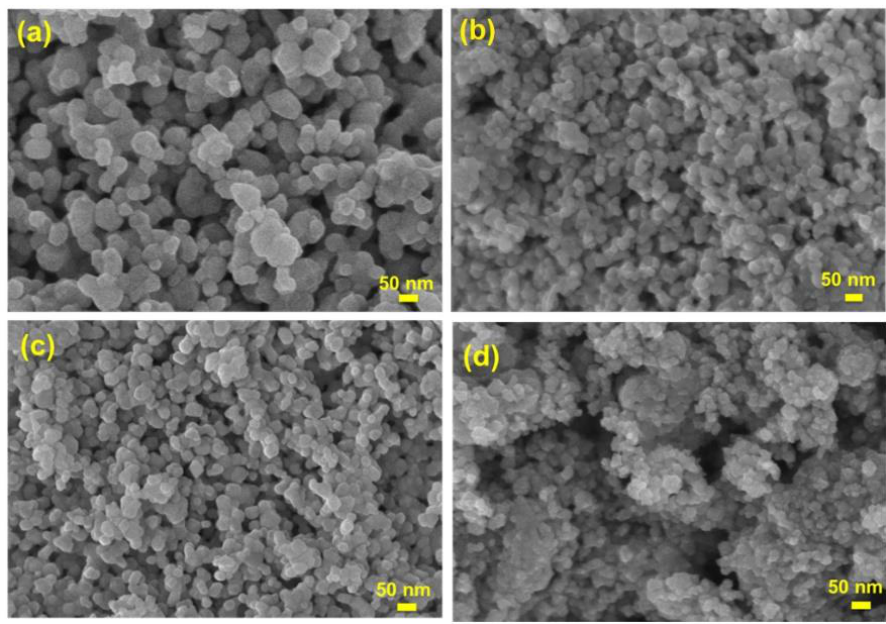
Figure 3. SEM photomicrography of ZnNd x Fe 2−x O 4 nanoparticles: ( a ) x = 0, ( b ) x = 0.01, ( c ) x = 0.03, ( d ) x = 0.05.